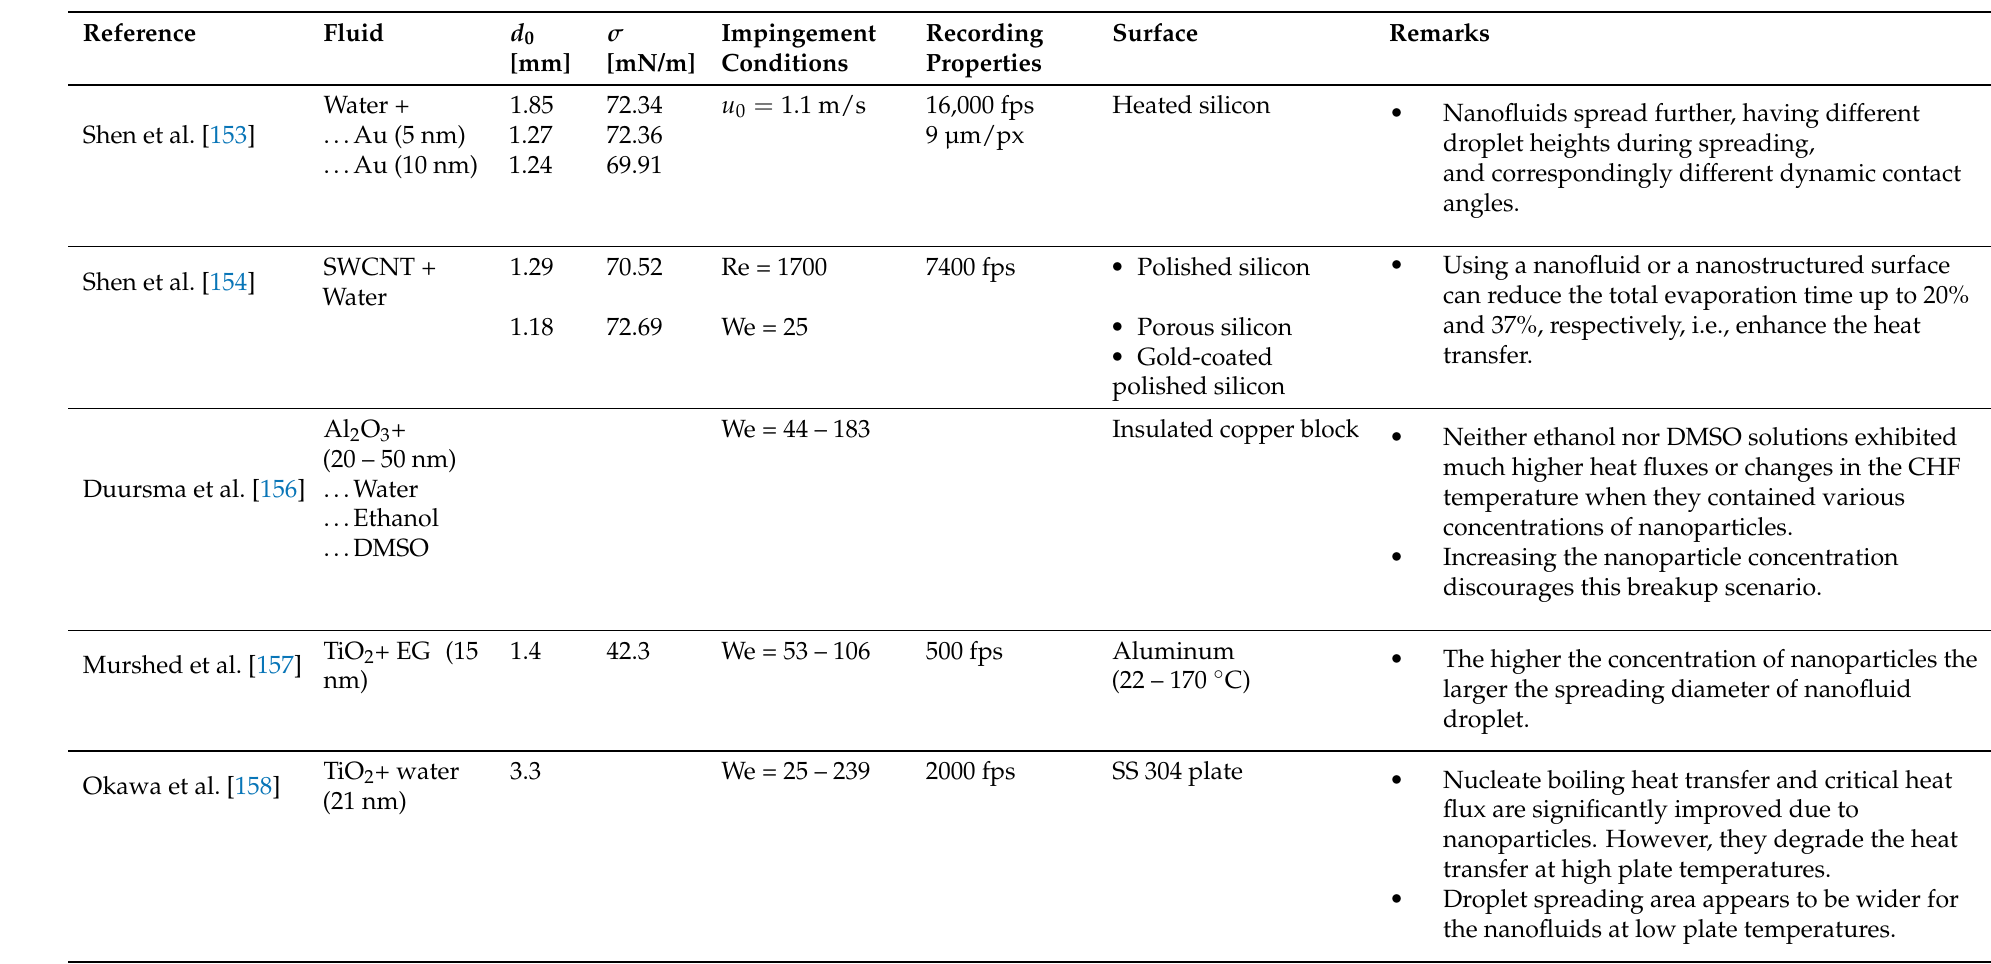
Table 1. Summary of the researches outcomes for nanofluid droplet